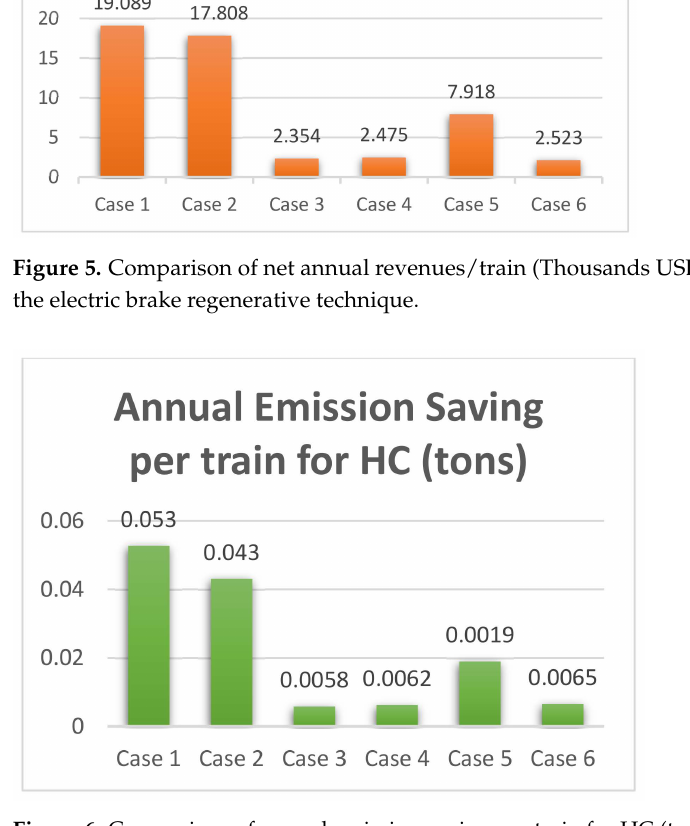
Figure 6. Comparison of annual emission saving per train for HC (tons) for the six cases when using the electric brake regenerative